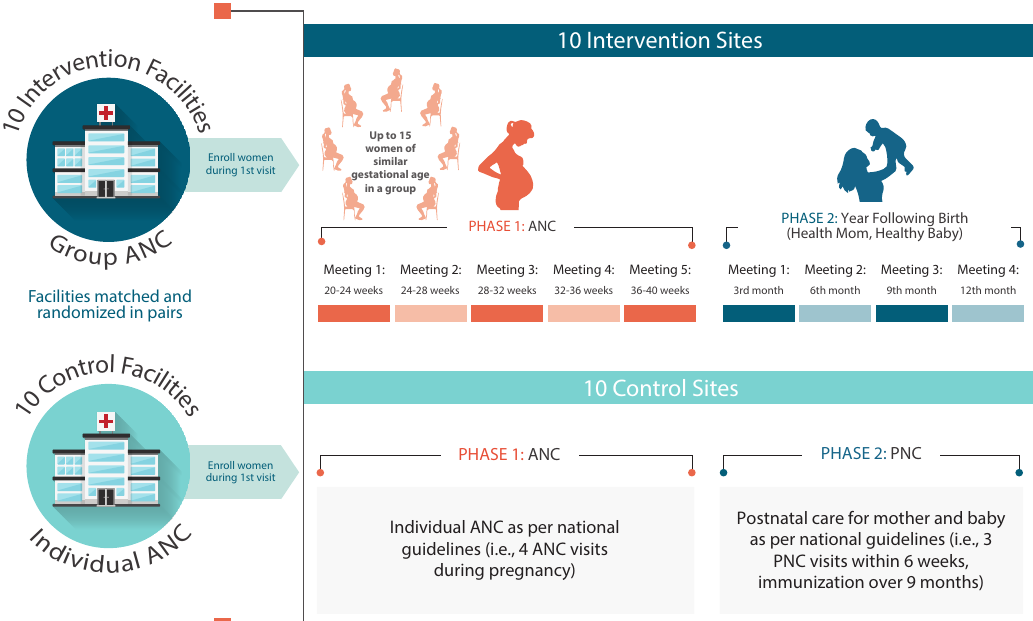
Figure 1. Study design. Description of randomization to intervention and control group and the intervention package for each study